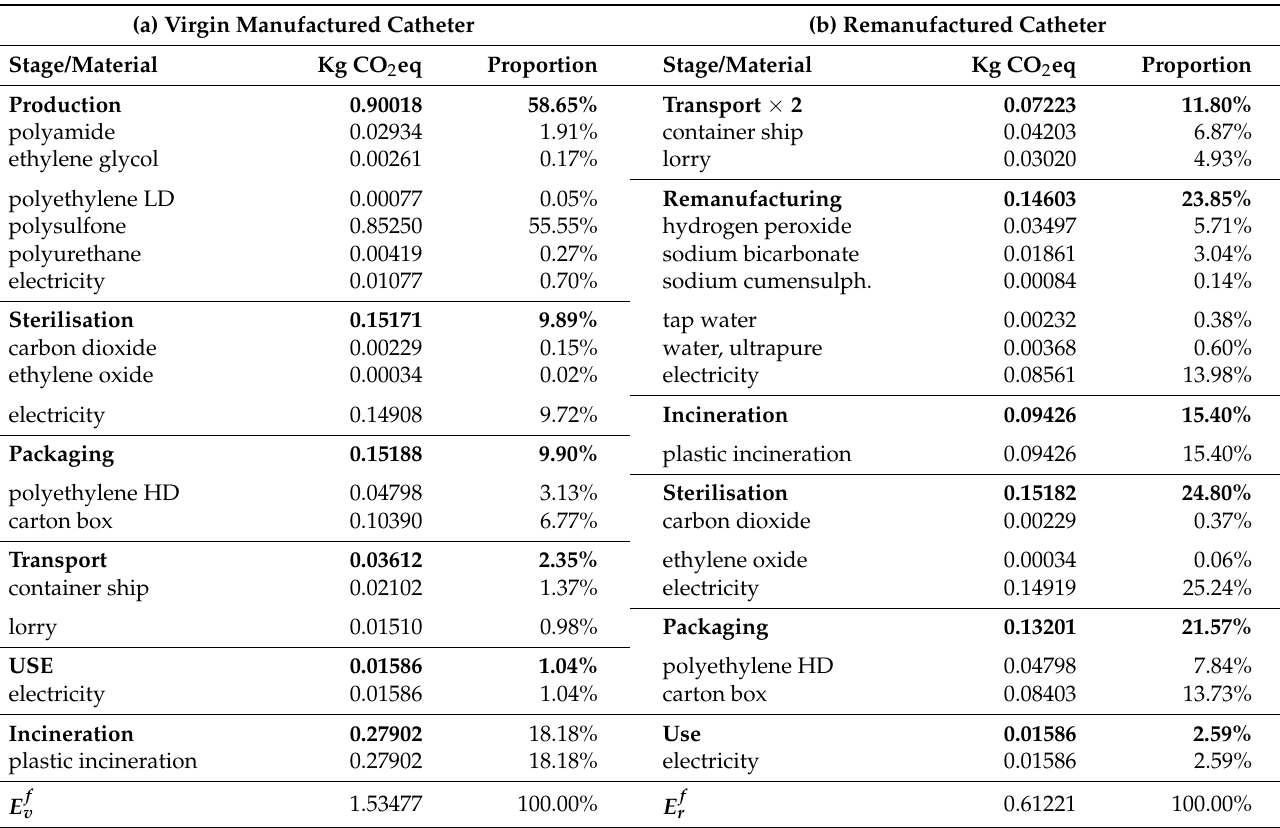
Table 5. Greenhouse gas emissions by life stage and material. Around three-quarters of virgin catheter emissions came form the production and disposal of plastic components. In comparison, remanufac- turing emissions were more evenly divided across life stages.